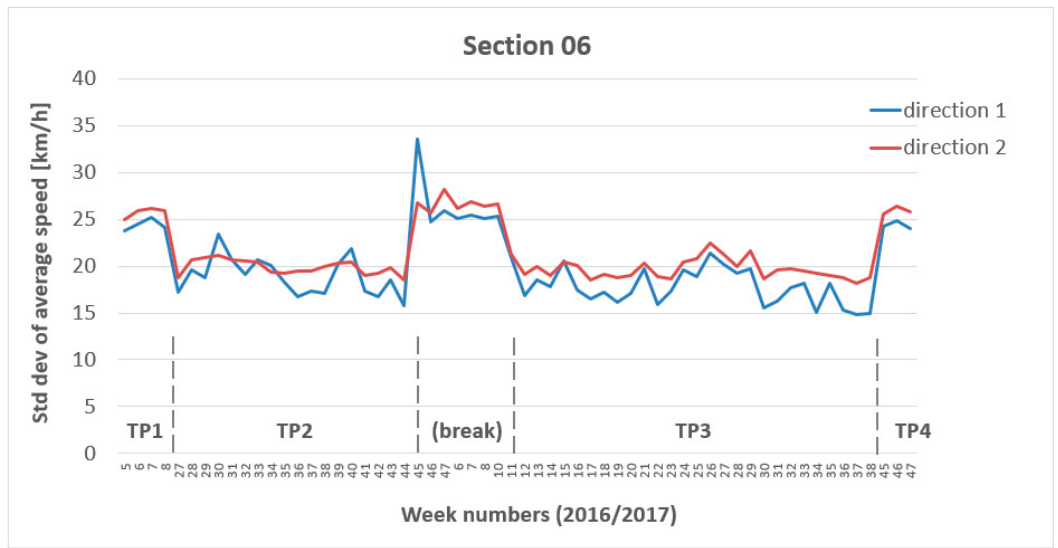
Figure 4. Example graph of standard deviation of average speed (speed variance).